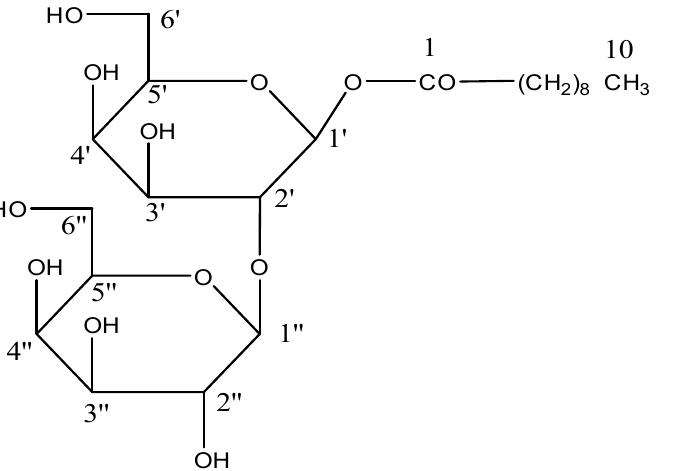
Figure 8. The diagnostic MS/MS fragmentation at m/z 792 full ESI-MS scan of the isolated compound n-deconoyl- β -D-glucopyranoryl-(2 (cid:48) → 1 (cid:48)(cid:48) )- β -D-glucopyranoside.